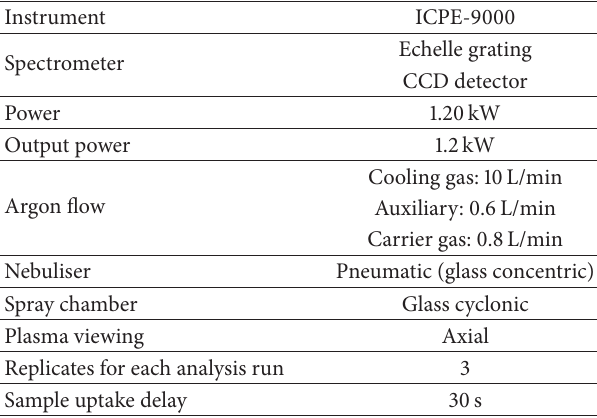
Table 2: Operating conditions of ICP-OES.